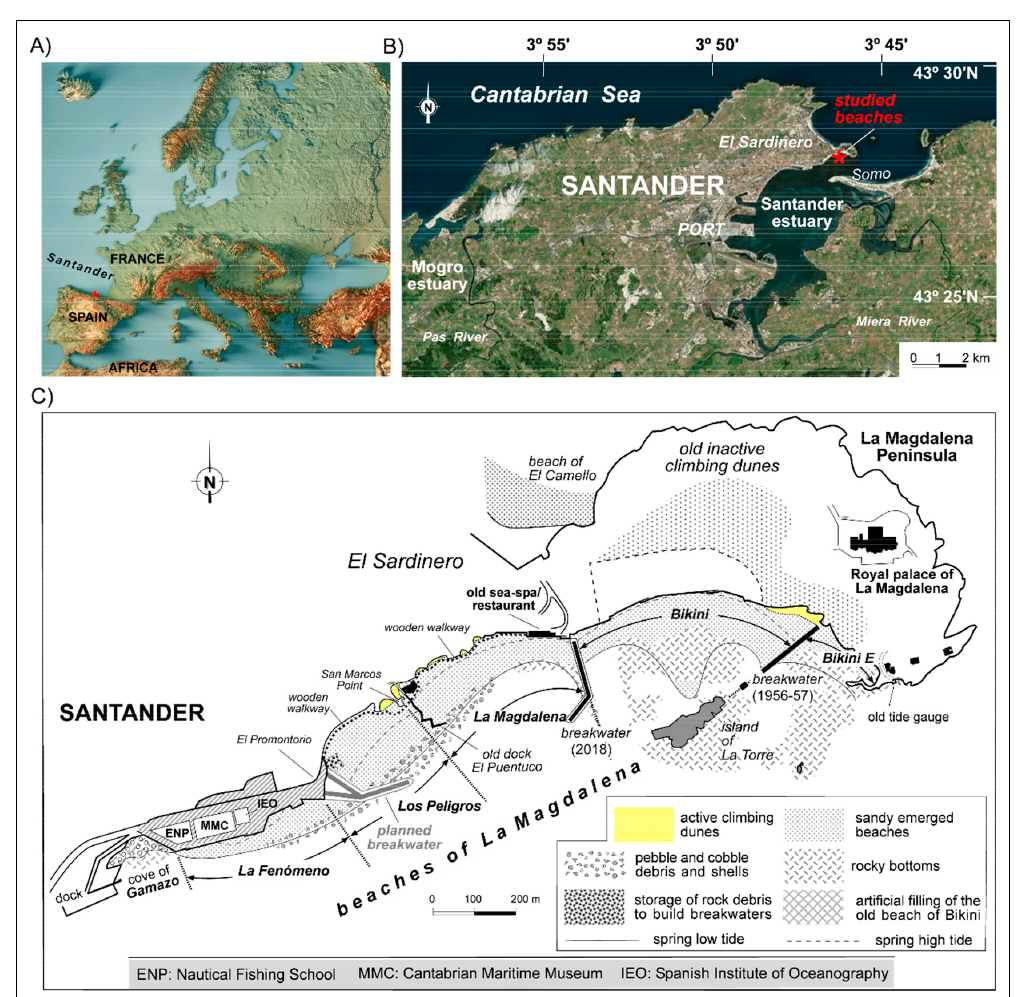
Figure 1. ( A ) Situation of the coast of Cantabria and city of Santander (Spain). ( B ) The area of study is situated in the outer western margin of the mouth of the Santander estuary. ( C ) Location of the beaches, the two breakwaters planned and other old civil structures and morphologies.